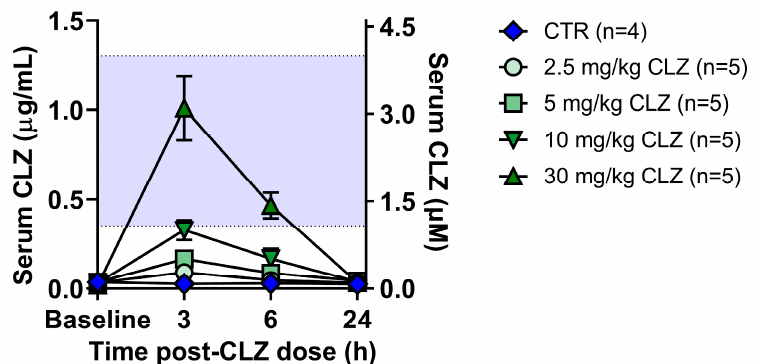
Figure 9. Measurement of clozapine blood levels in rats by LC-MS/MS. Serum drug concentrations in female Sprague Dawley rats over 24 h following treatment with vehicle (control) or clozapine (2.5, 5, 10, or 30 mg/kg, IP). Drug concentrations were measured using a TSQ Altis Triple Quadrupole Mass Spectrometer interfaced with a 1260 Infinity II Prime LC System and analyzed using XCalibur software. Results are presented as the mean ± SD, where the purple shaded area represents the average therapeutic range reported in patients [94]. CTR, control; CLZ, clozapine.